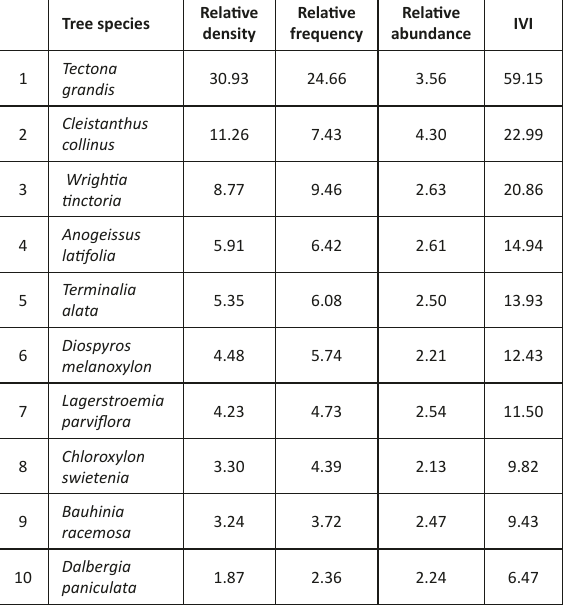
Table 2. Analysis of saplings (below 30 GBH). Tree